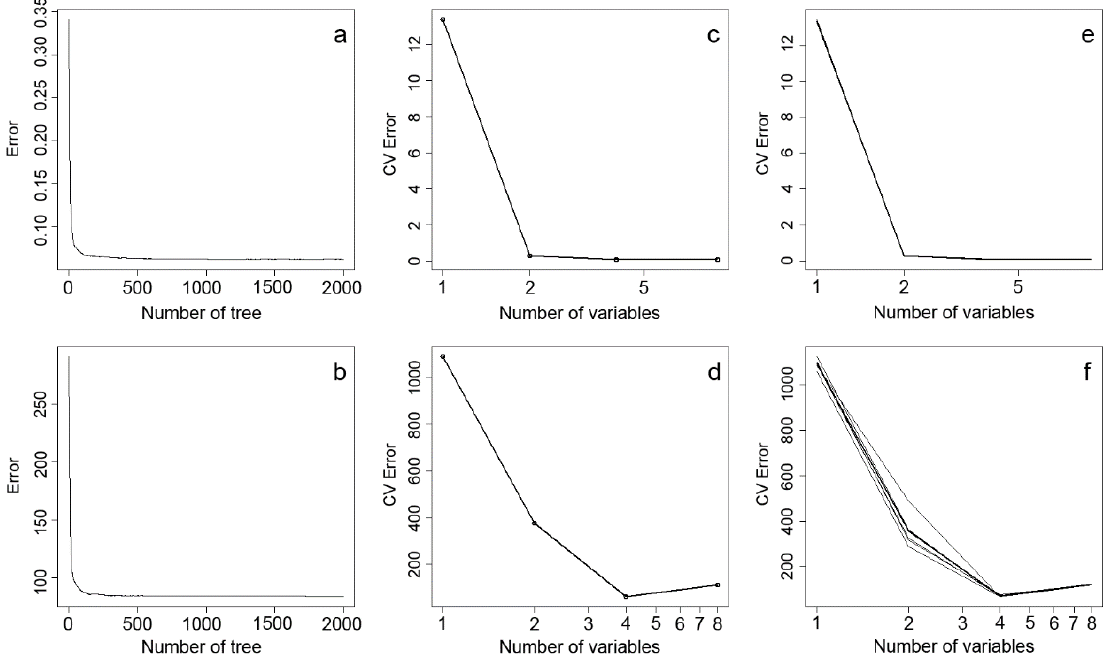
Figure 5. Random forest error graphs. ( a , b ) Relationship between the number of trees and the error of the RF model for PM 2.5 and FCE, respectively; ( c , d ) relationship between the number of variables and the error of the RF model for PM 2.5 and FCE under 10-fold cross-validation, respectively; ( e , f ) relationship between the number of variables and error of RF model for PM 2.5 and FCE under multiple cross-verifications, respectively.